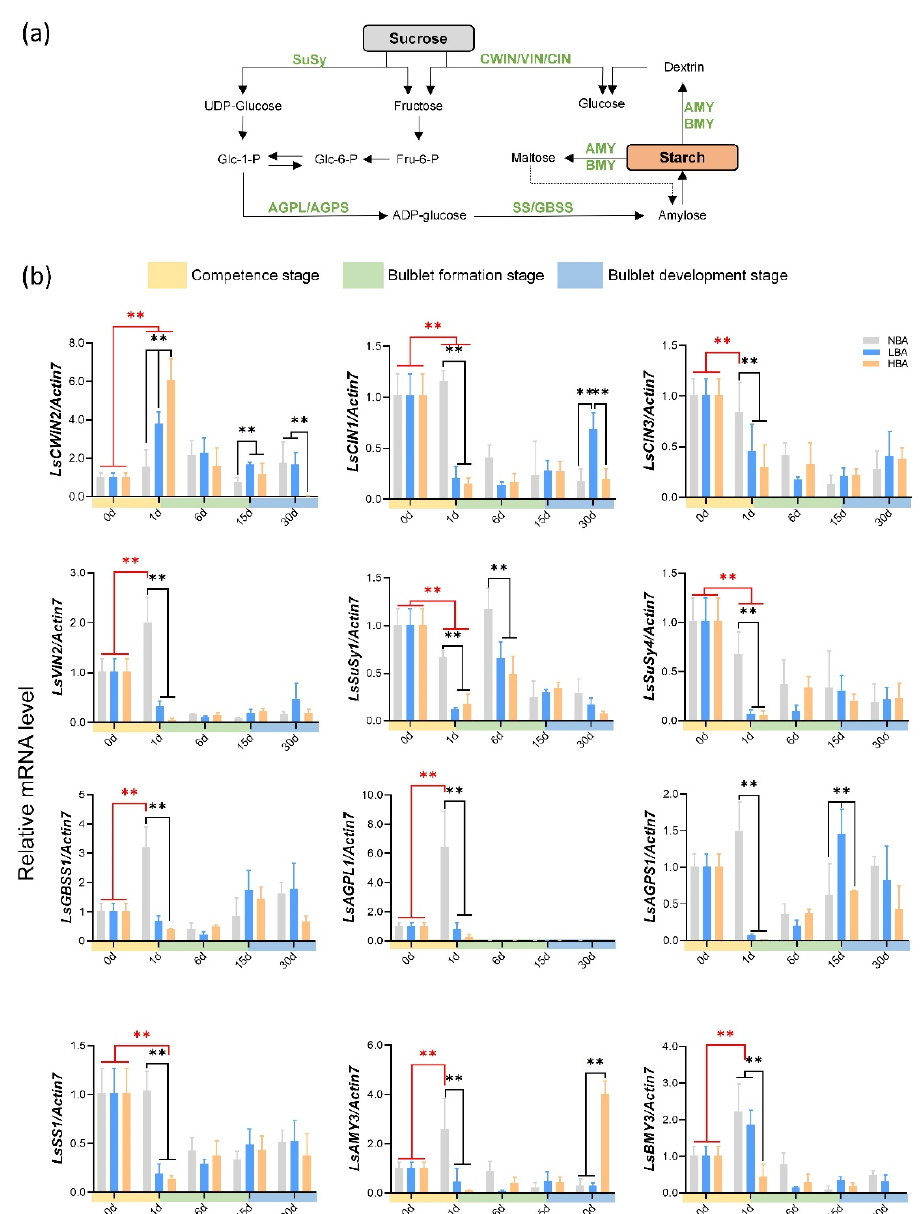
Figure 6. Relative expression of sucrose and starch metabolism-related genes in each group during in vitro bulblet regeneration. Data are represented as the means ± SEM ( n = 3 biological replicates). SuSy: sucrose synthase, CWIN: cell wall invertase, VIN: vacuolar invertase, CIN: cytoplasmic invertase, AGPL: the large subunit of adenosine 5 (cid:48) -diphosphate glucose pyrophosphorylase (AGP), AGPS: the small subunit AGP, GBSS: granule-bound starch synthase, SS: soluble starch synthase, AMY: alpha-amylase, BMY: beta-amylase. Asterisks indicate significant differences between column (red) or within each column (black) (Duncan’s multiple range test, ** p < 0.01).